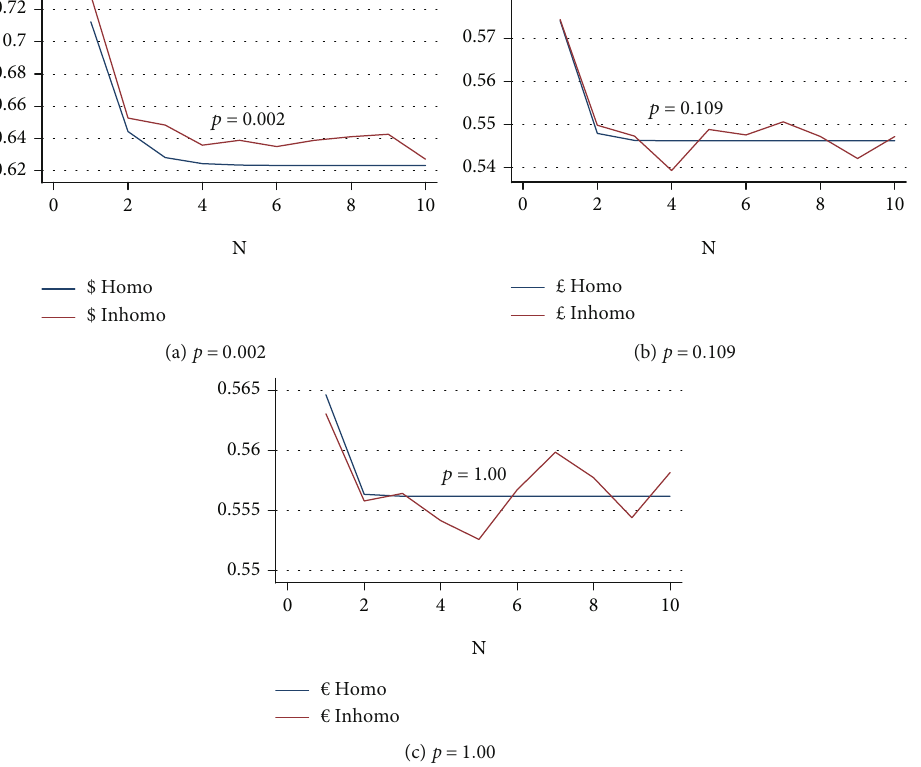
Figure 3: Plot of n th step transitional probabilities of time-homogenous and time-inhomogeneous by currency. Notes: HOMO means “ time- homogenous ” ; INHOMO means “ time-inhomogeneous.